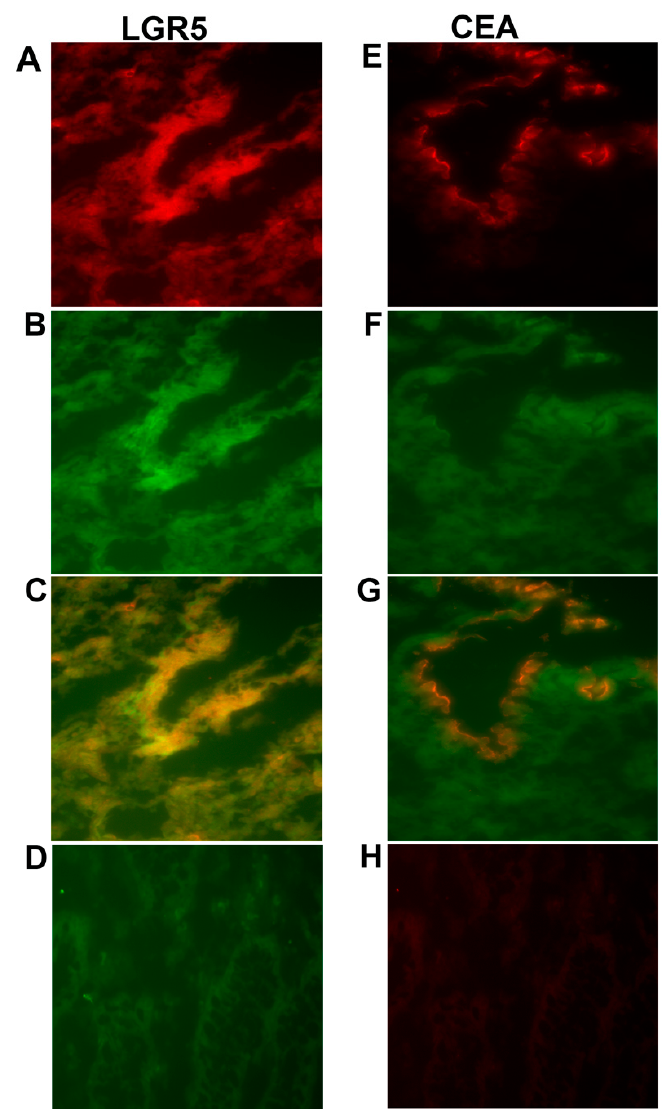
Figure 3. Two-color immunofluorescence staining of primary colon cancer tissue with anti-LGR5 and BerEP4, and anti-CEA and BerEP4. ( A ) Anti-LGR5, ( E ) Anti-CEA both red color. ( B , F ) BerEP4 mAb, green color. ( C , G ) Overlays giving yellow color of double-stained areas. ( D ) FITC-conjugated mouse IgG; negative control for BerEP4. ( H ) Rabbit IgG; negative control for anti-LGR5 and anti-CEA. Original magnification: ×200.